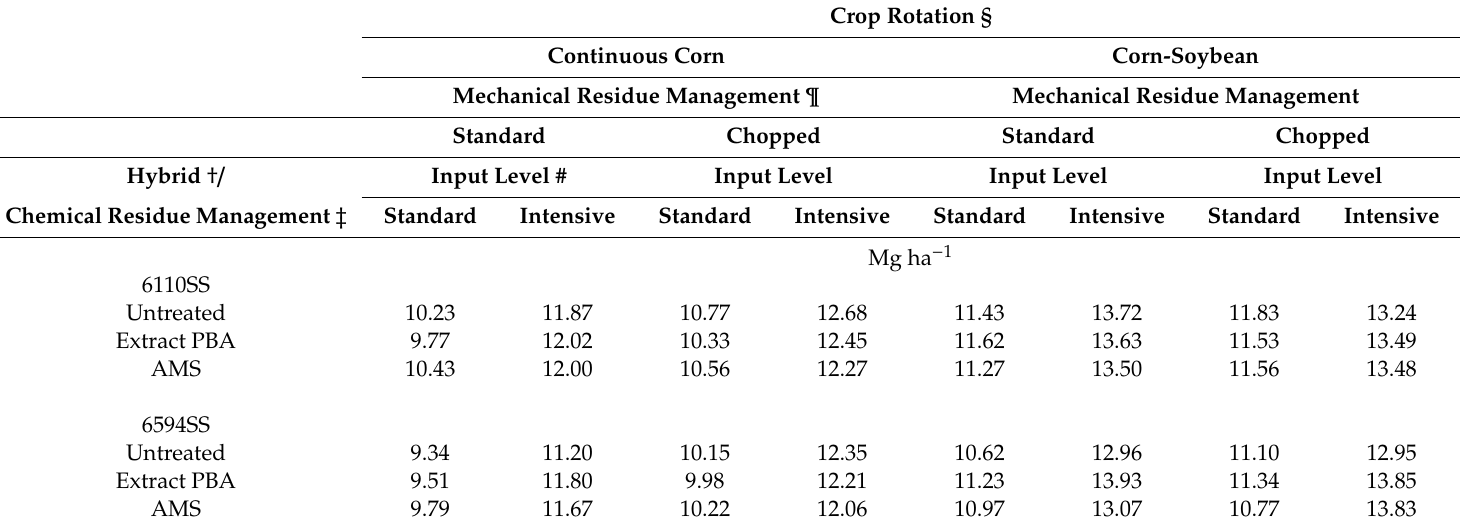
Table 8. Corn grain yield for two hybrids as influenced by crop rotation, mechanical and chemical residue management, and agronomic input level. Hybrids were grown in continuous corn (15 th year) and following soybean rotations at Champaign, IL in 2017 and 2018. All values are reported at 0 g kg − 1 moisture